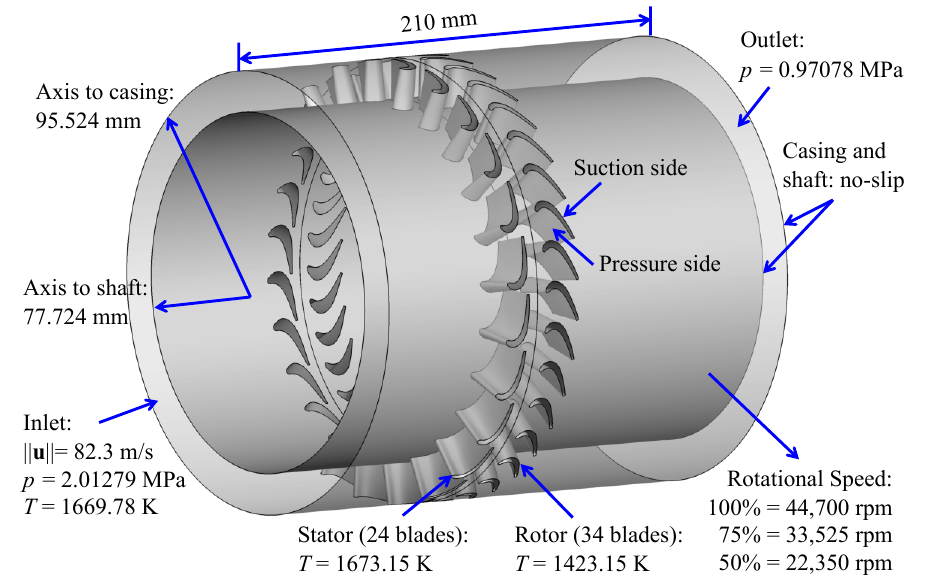
Figure 2. Turbine stage problem